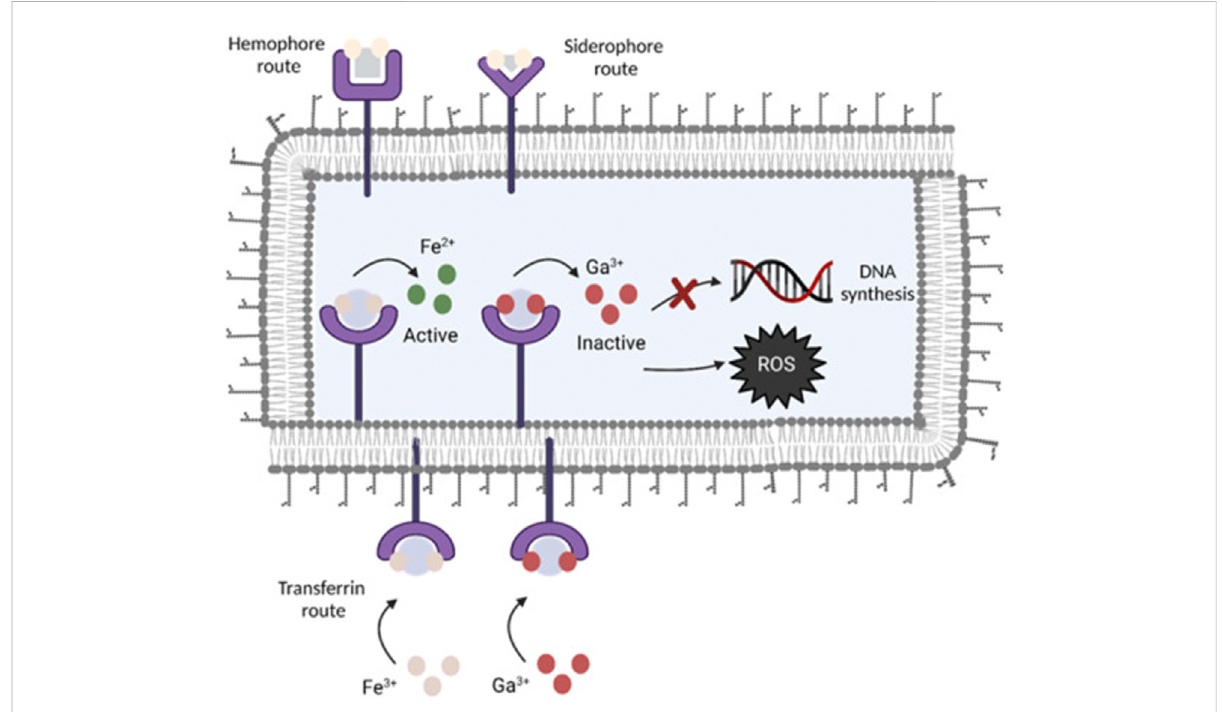
FIGURE 3 Gallium ’ santimicrobialactionisshownschematically.Byutilizingtransferrin,homophora,andsiderophoreasFe-uptakepathways,Gaisableto get through the cytoplasmic membrane of bacteria. Because gallium cannot be reduced, it interferes with vital biological processes like respiration, DNA synthesis, and oxidative stress reactions (Kurtuldu et al., 2022). Copyright 2022, Bioactive